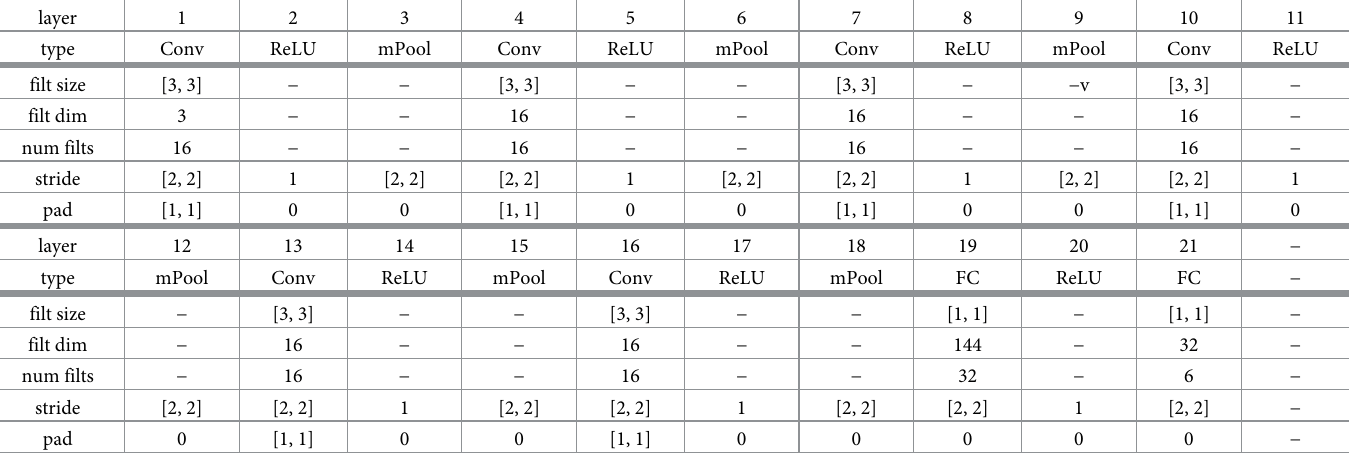
Table 1. Localisation network details of spatial transformers used for the normalized face image.